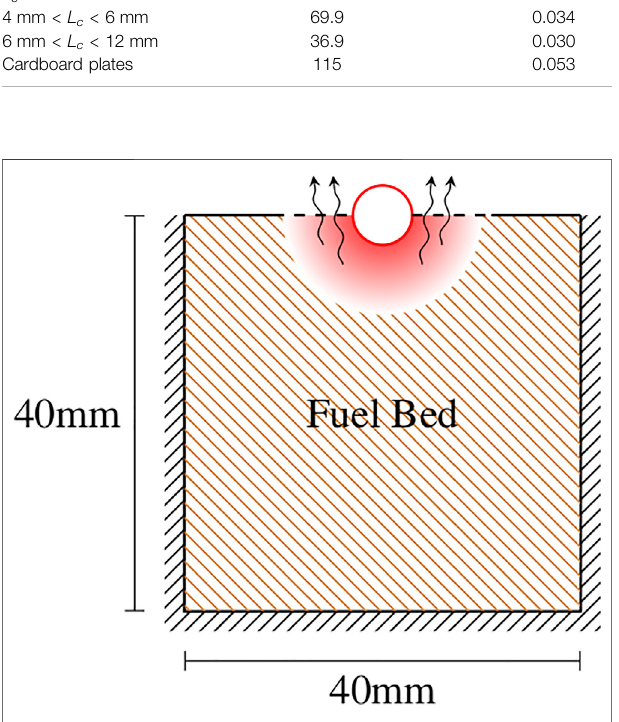
FIGURE 2 | Diagram of the computational domain where black lines indicate domain boundaries, and red lines are boundaries de fi ned by the heater.Thearrowsdenote fl owofpyrolysisproductsfromthefuelbedintothe air above the fuel bed.